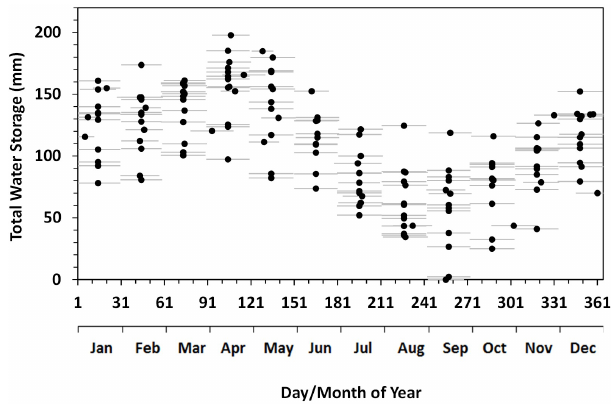
Figure 6. Monthly total water storage (TWS) for the Albany River watershed over the study period (2002–2016, relative to the mini- mum value for the period). The grey lines represent the time period of GRACE observations used for deriving the TWS.